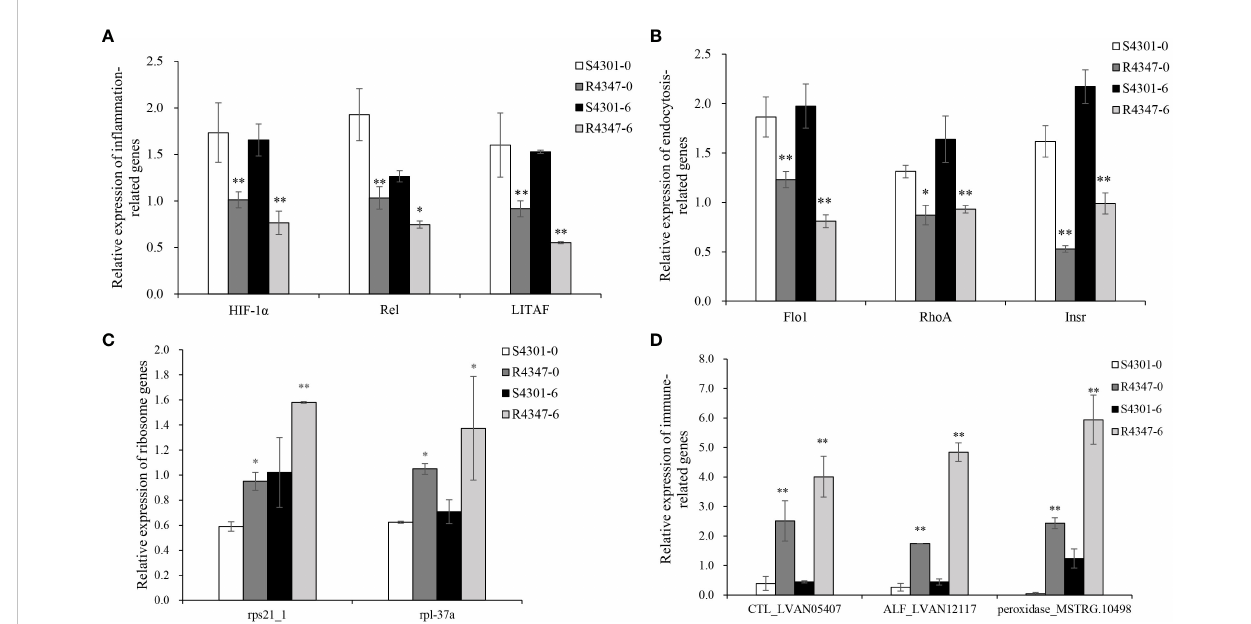
FIGURE 7 The relative expression of DEGs in the gills from the susceptible family S4301 and the resistant family R4347. (A) In fl ammation-related genes. (B) Endocytosis- related genes. (C) Ribosome genes. (D) Immune-related genes. Vertical bars represent the mean ± S.E. (n = 3). Signi fi cant differences between R4347 and S4301 at the same sampling point are indicated with an asterisk at P < 0.05, and two asterisks at P <